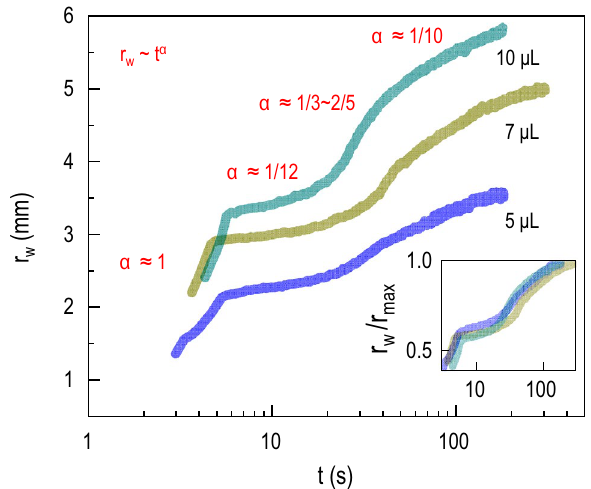
Figure 3. Wetted area radius evolution at early times. Wetted area radius r w change with time during 0 < t < 200 s for the fabric substrate, where different initial volumes are compared. The exponent α in the power-law scaling r w ∼ t α are represented for each slope. The inset represents the nondimensionalized data ( r w / r max (maximum r w )) to compare the power-law scaling between different droplet